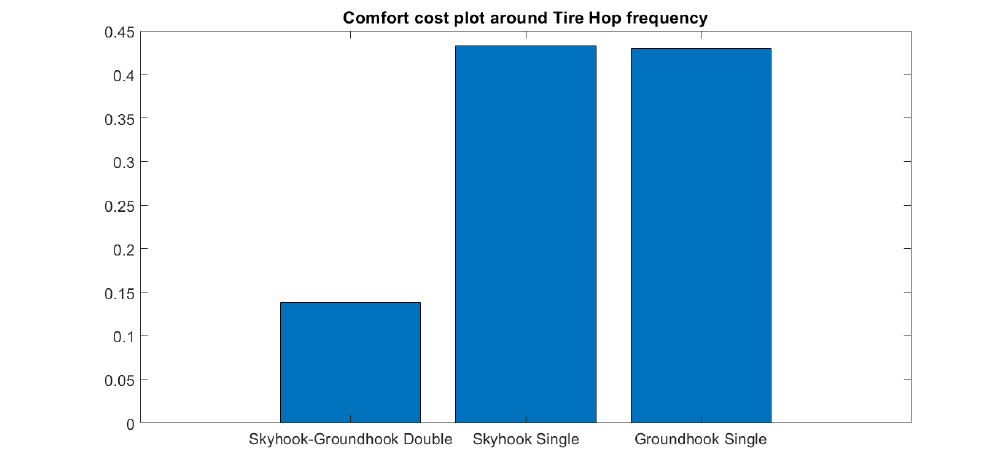
Figure 13. Normalized comfort cost plot—Comparing double-damper with control and single-damper with control, in Chassis frequency zone.